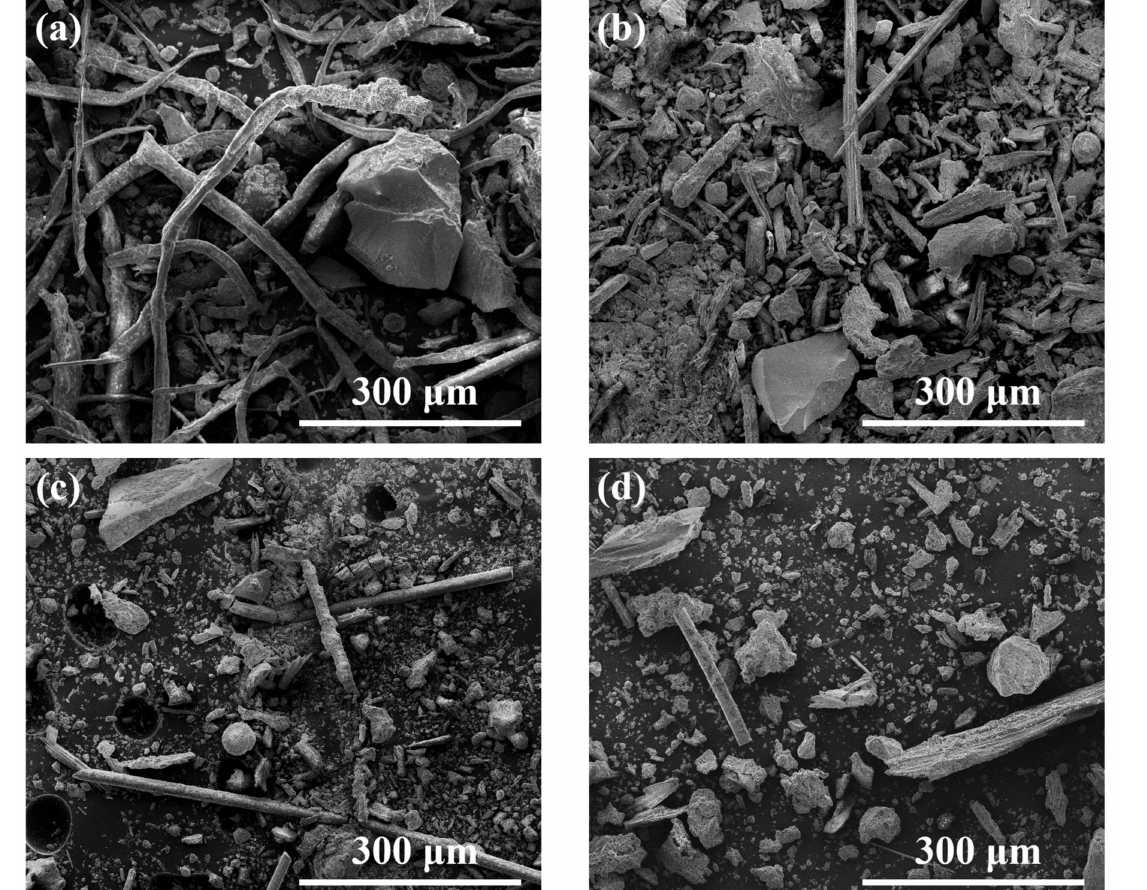
Figure 8. SEM images of ( a ) USF and hydrochars produced at 220 ◦ C for ( b ) 1 h; ( c ) 4 h; ( d ) 8